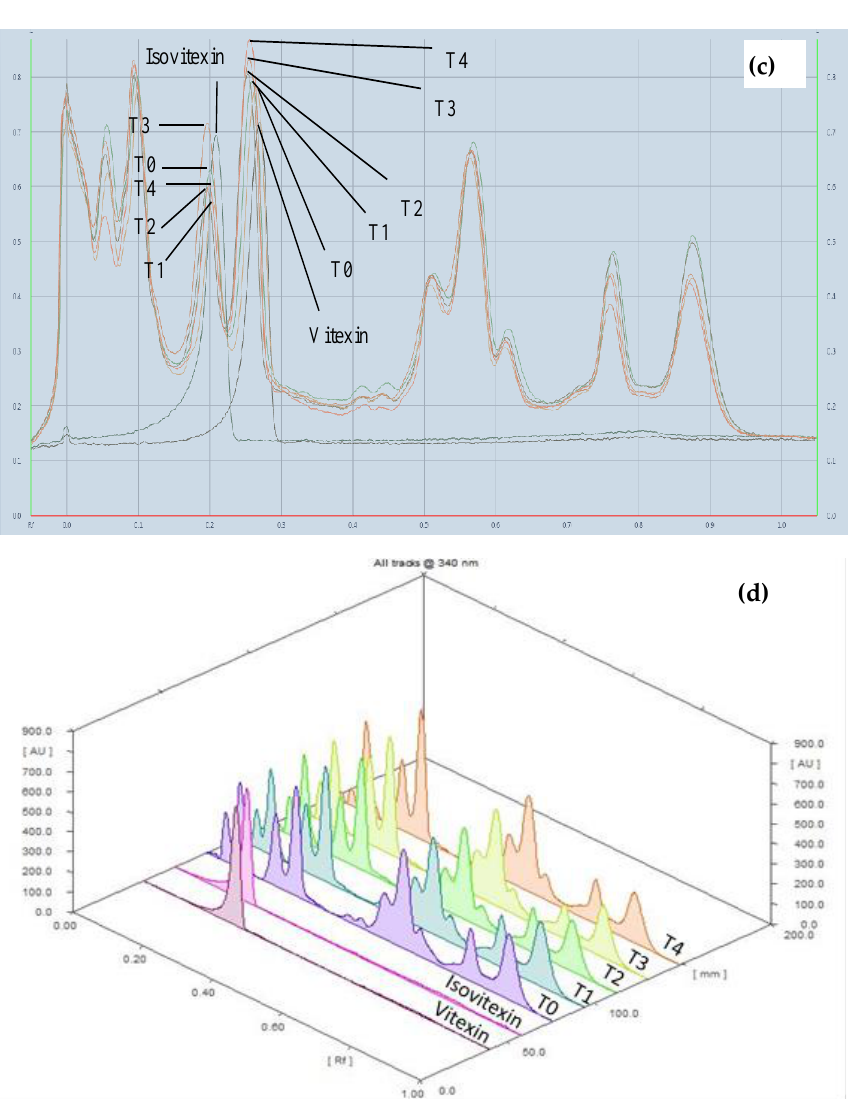
Figure 5. Visualization of the sample (T0, Control; T1, 8 mM; T2, 16 mM; T3, 30 mM; T4, 60 mM) with selected markers (Vitexin, Isovitexin) under 254 nm wavelength ( a ) and 366 nm wavelength ( b ), 2D densitogram ( c ) and 3D densitogram ( d ).